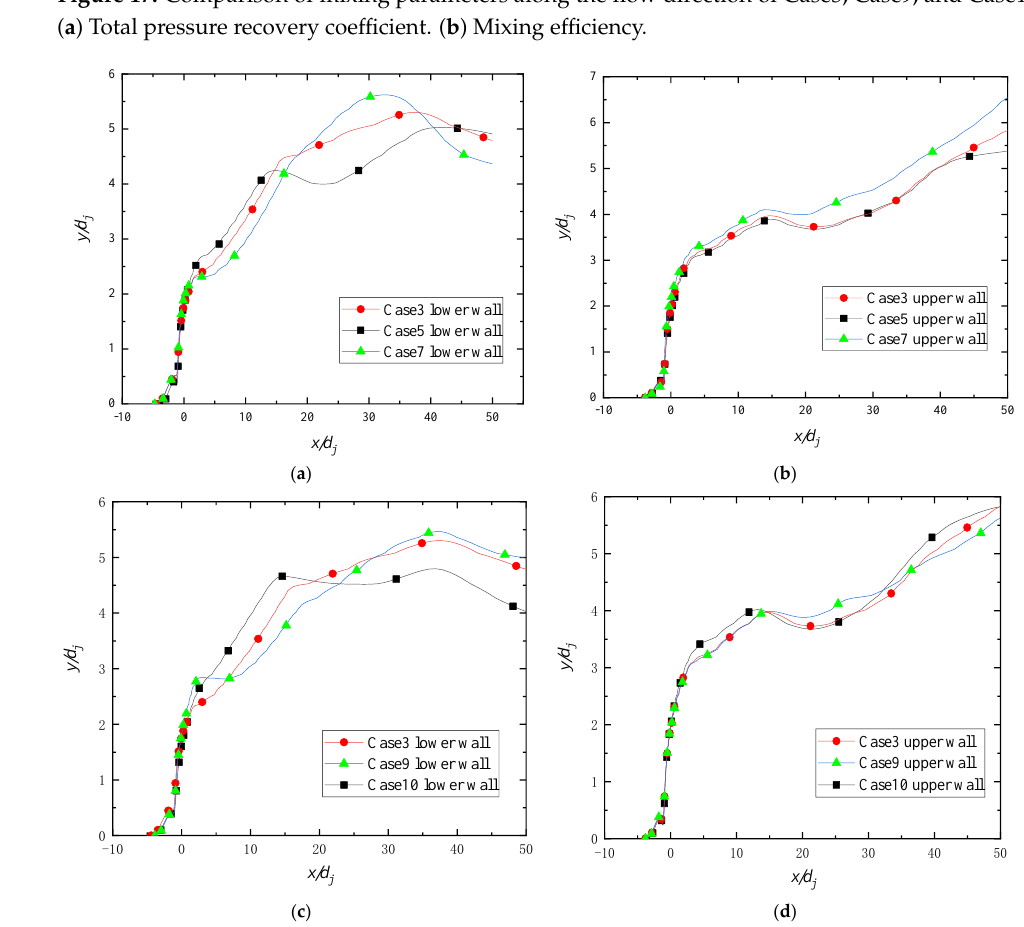
Figure 18. Comparison of the fuel penetration depth in various cases. ( a ) Fuel penetration depth on the lower wall of Case3, Case5, and Case7. ( b ) Fuel penetration depth on the upper wall of Case3, Case5, and Case7. ( c ) Fuel penetration depth on the lower wall of Case3, Case9, and Case10. ( d ) Fuel penetration depth on the upper wall of Case3, Case9, and